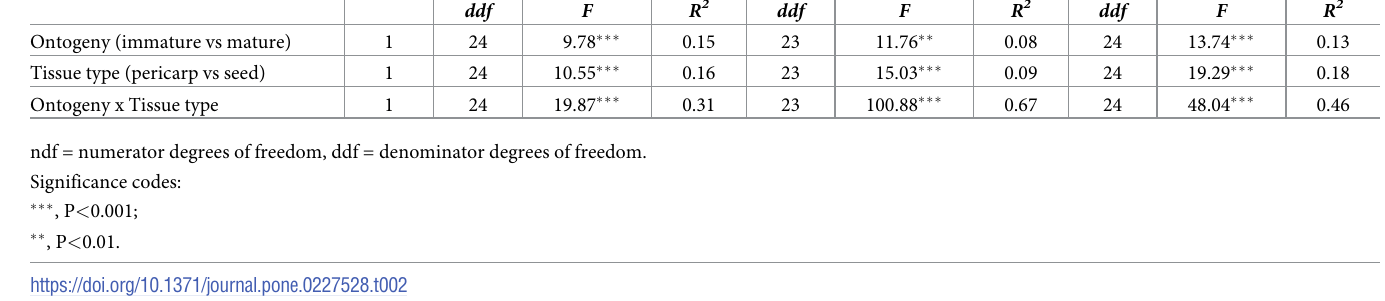
Table 2. Permutational multivariate analysis of variance (PERMANOVA) using Kulczynski distance matrices on the effects of ontogeny (mature and immature), and tissue type (pericarp and seed) on glucosinolate composition in Lepidium appelianum , L . campestre and transgenic RNAi- LcIND L . campestre (n = 6–7). Factors ndf Lepidium appelianum Lepidium campestre RNAi- LcIND L . campestre ddf F R 2 ddf F R 2 ddf F R 2 Ontogeny (immature vs mature) 1 Tissue type (pericarp vs seed) Ontogeny x Tissue type